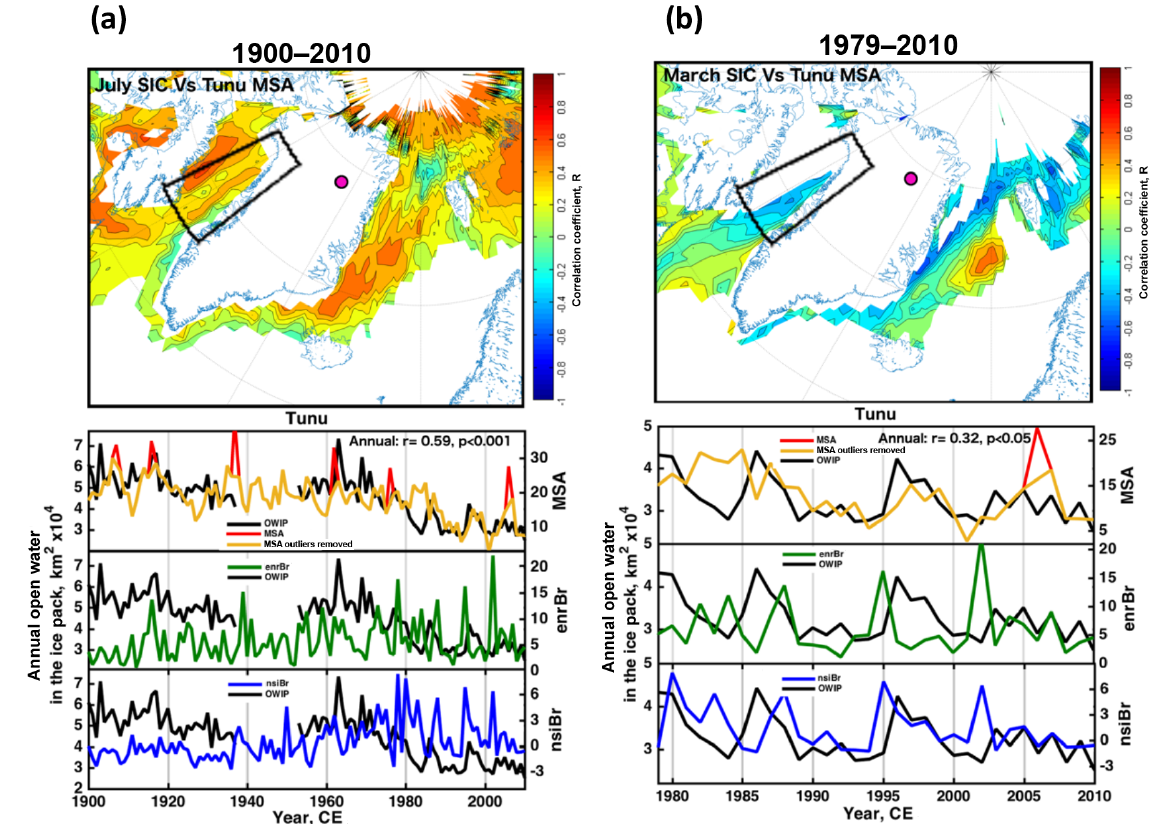
Figure 7. Upper panels: correlation maps of monthly sea ice concentration (SIC) derived from the Tunu ice core. (a) HadISST1 ICE dataset from 1900 to 2012CE correlated with annual records of MSA. The monthly SIC map displayed corresponds to the month which shows the highest OWIP correlation (lower panels) with the annual MSA. Other monthly maps are shown in Fig. S10. Only locations that showed a SIC variability greater than 10% and have a significant correlation ( t test, p < 0.05) are displayed. The area of sea ice that is the likely source of MSA (as indicated by the air mass trajectories) are outlined in black (77–67 ◦ N, 62–50 ◦ W). (b) As for (a) but focused on the satellite period 1979–2012CE. Lower panels: the correlation between the area of open water within the ice pack (OWIP) calculated within the black outlined areas shown on the upper maps and the annual MSA records (red) with outliers removed (orange). The Tunu enrBr(Na) and nsiBr records (in nM) are also compared to the same OWIP records and show poor correlation, particulary over the longer time